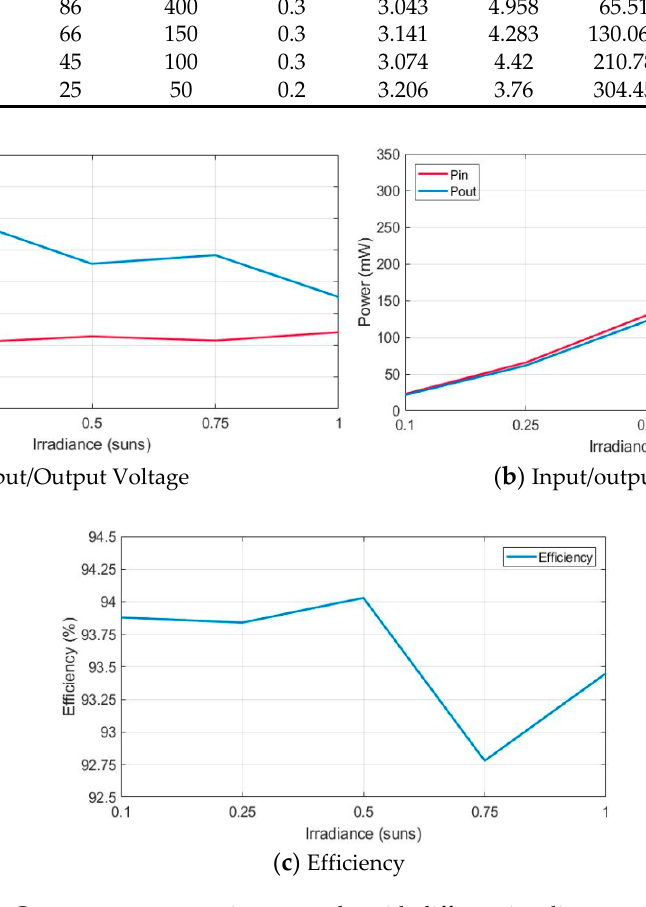
Figure 14. Converter sweep maximum results with different irradiance and temperature.